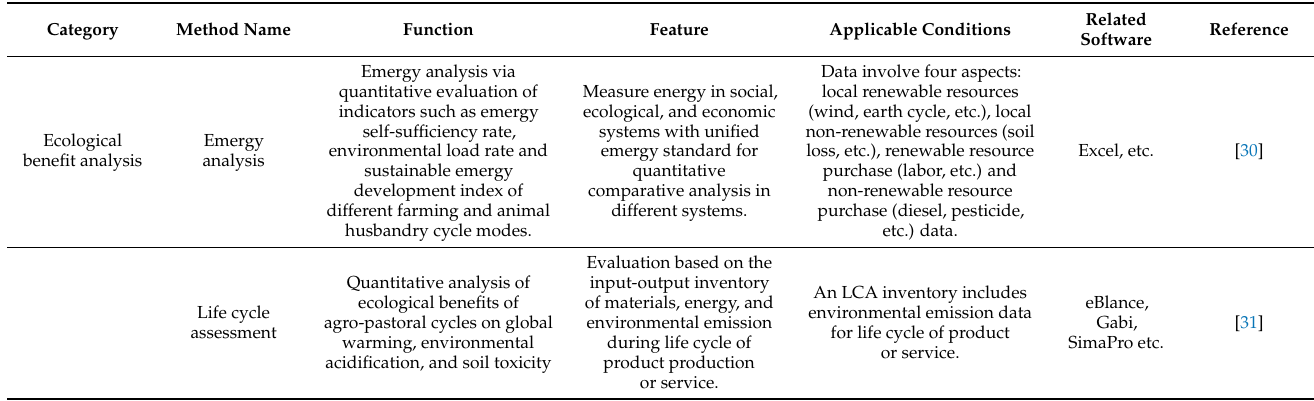
Table 1. Methods to analyze the benefits of crop–livestock